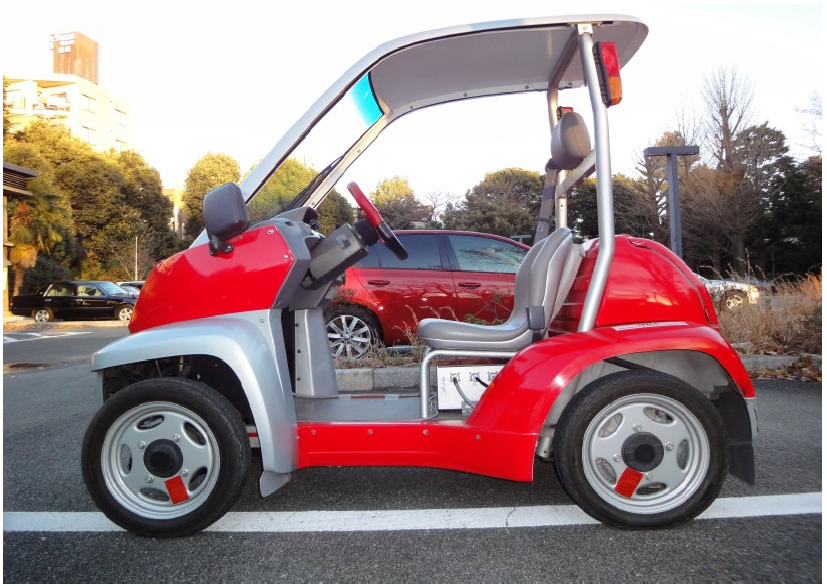
Figure 1. Experimental personal electric vehicle.